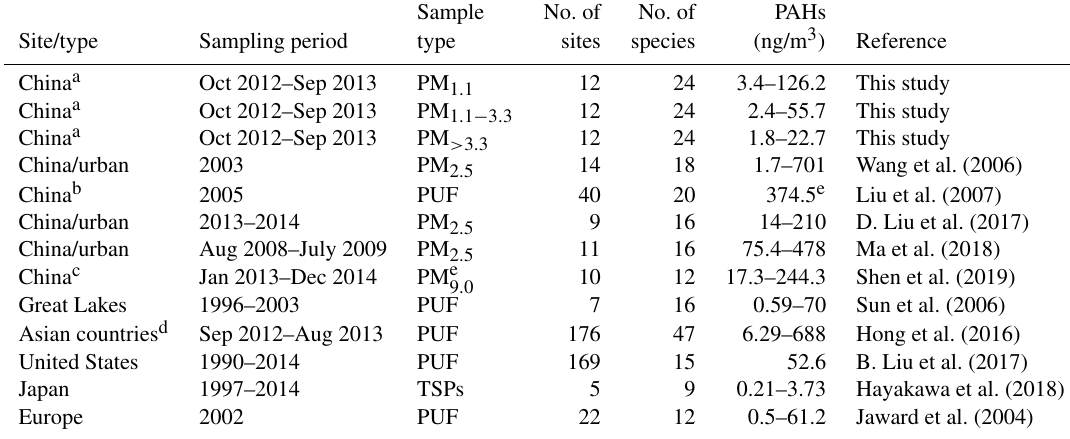
Table 1. PAHs’ concentration measured in this study and comparison with those of other large-scale observations. Sample No. of No. of PAHs Site/type Sampling period type sites species (ng/m 3